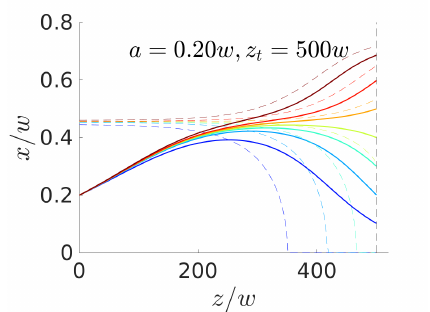
Figure 6. Solid lines: Optimal particle trajectories in the x - z plane found for steering colloids with radius a = 0.2 w from the initial position x i = 0.2 w to a set of targets Dashed lines: Sequence of fixed-point positions of the lift-force profiles resulting from the optimal control-force protocols f ctl ( t ) (same colors represent the same force